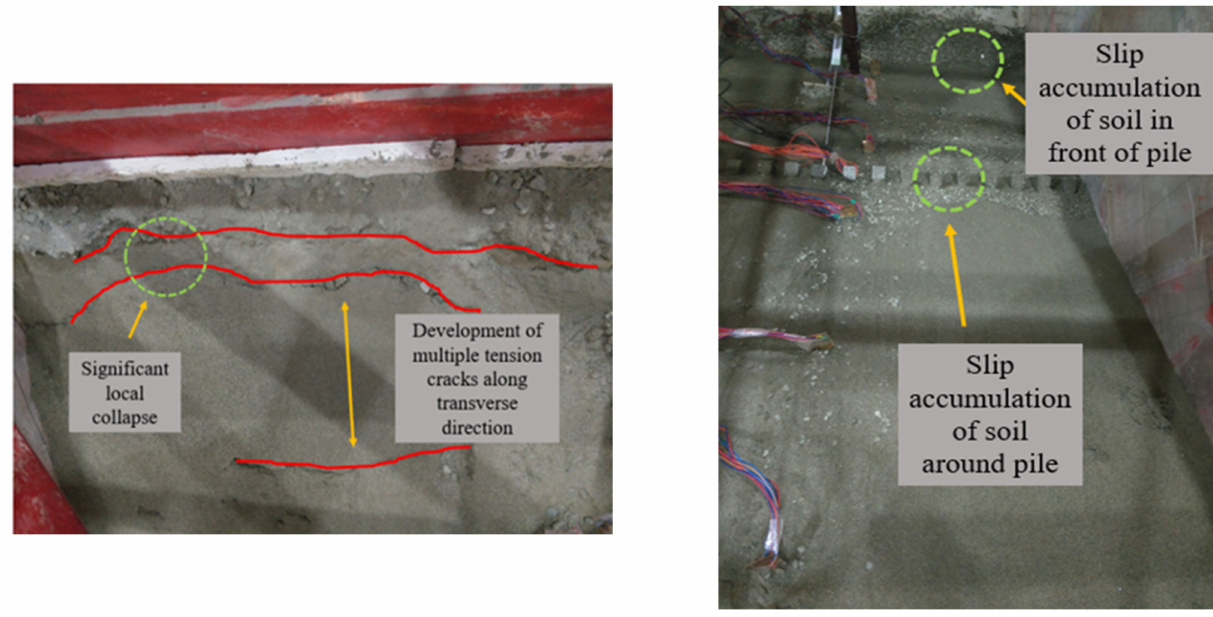
Figure 9. The top, middle and toe of the slope after 0.6 g sine wave 4th loading. For group B, the phenomenon of 0.1~0.4 g sine wave loading was similar to that of group A, and the slope was relatively stable. After the sine wave reached 0.5 g,